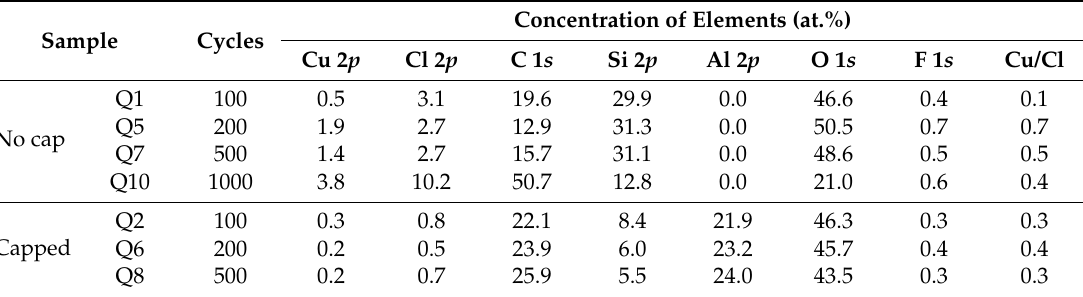
Table 2. Element concentration obtained from X-ray photoelectron spectroscopy (XPS) survey scan (not Ar-sputtered).